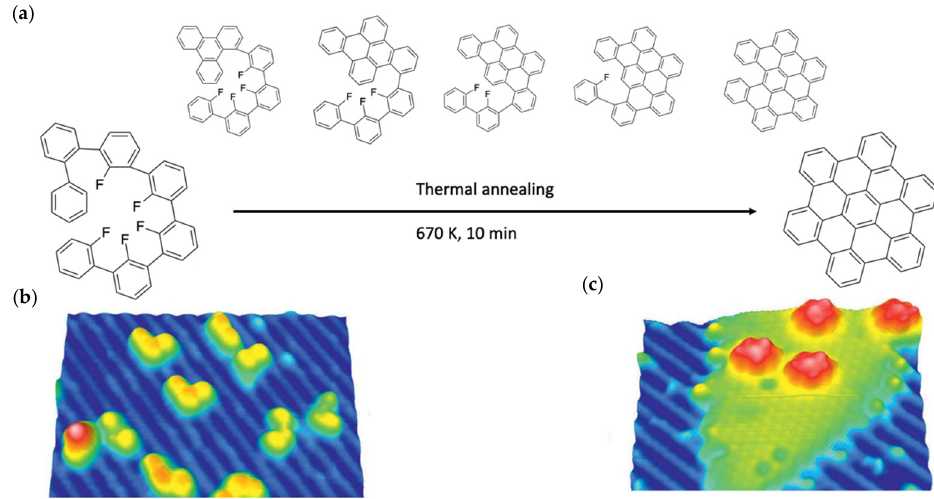
Figure 6. ( a ) Chemical pathway for the thermal-induced transformation of dibenzo[ij,rst]phenanthro[9,10,1,2-defg]pentaphene (DBPP) into hexabenzocoronene (HBC) on the rutile TiO 2 (011)-2x1 surface. ( b ) STM image of DBPP (V s = 2.0 V, I t = 10 pA, 298 K, 13 × 10 nm 2 ). ( c ) STM image (V s = 2.5 V, I t = 50 pA, 298 K, 9 × 7 nm 2 ) of HBC molecules obtained after thermal annealing of DBPP molecules.